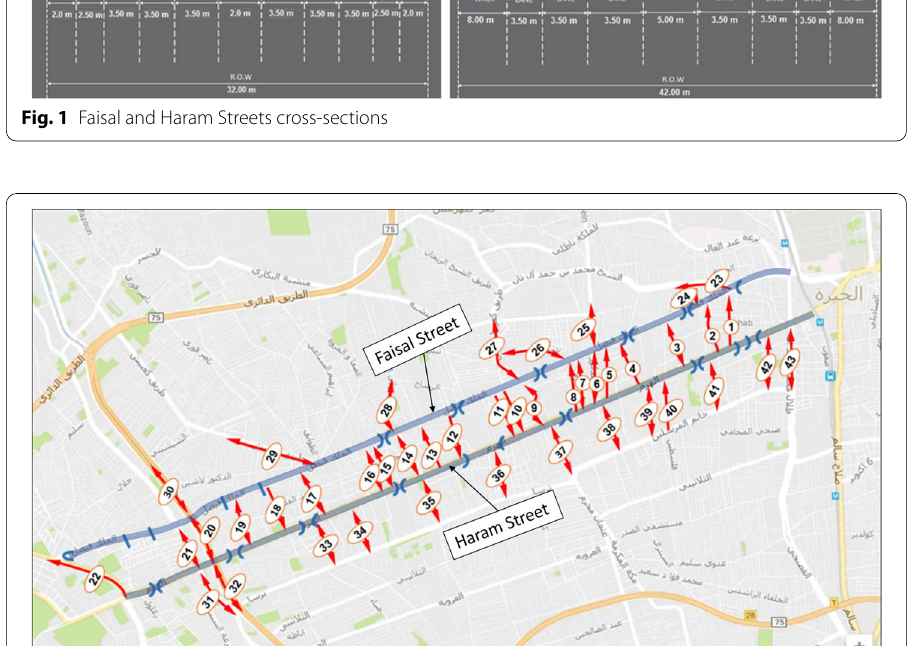
Fig. 2 Side streets and existing U-turns on Faisal and Haram